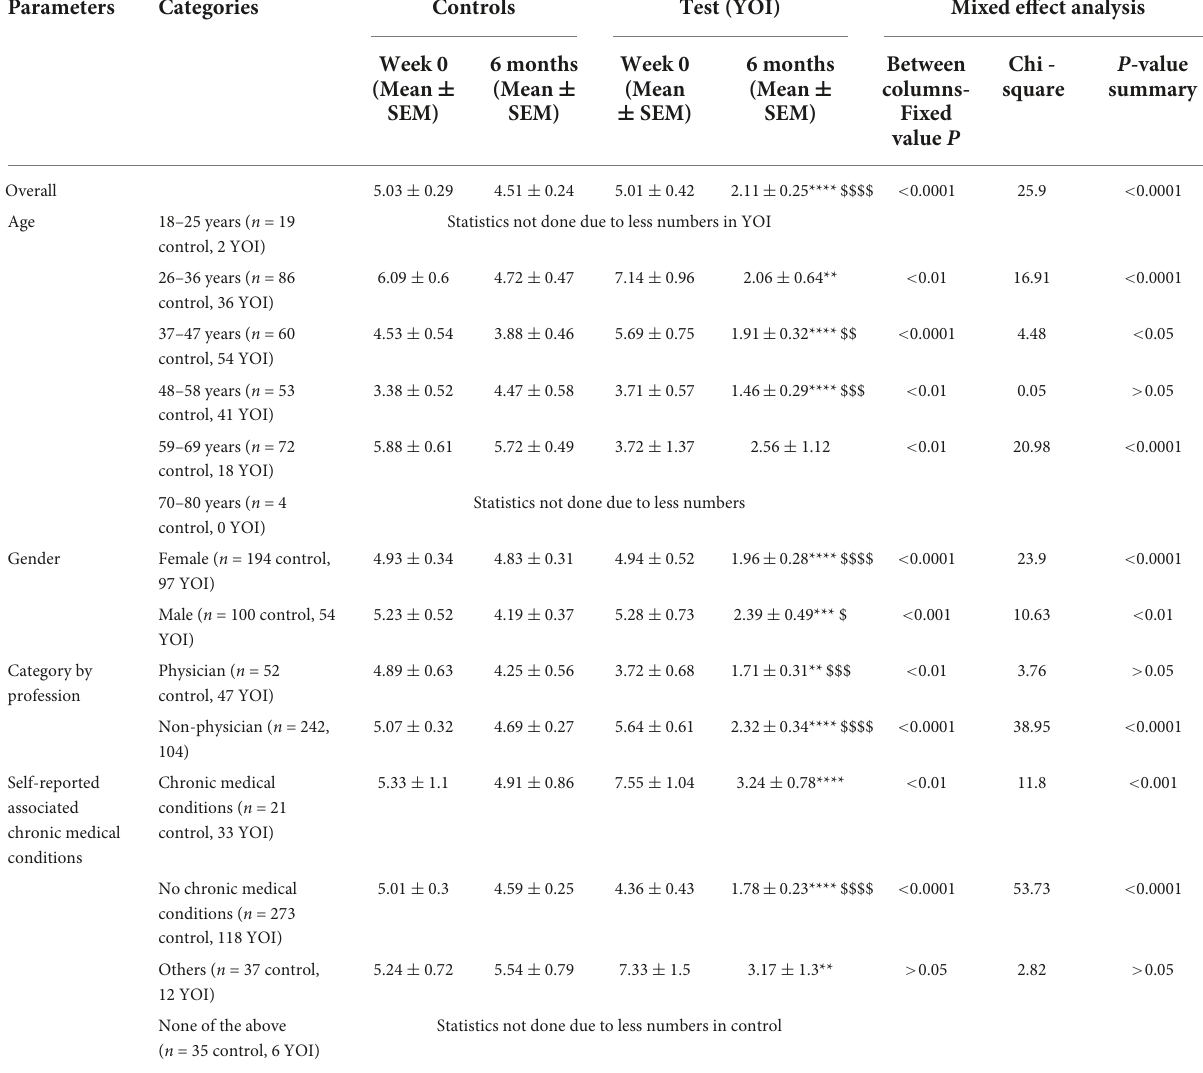
TABLE 2 Overall mean total GAD-7 score and mean total GAD-7 scores for demographic parameters in control and YOI group, at week 0 and after completing 20 weeks of the YOI program.